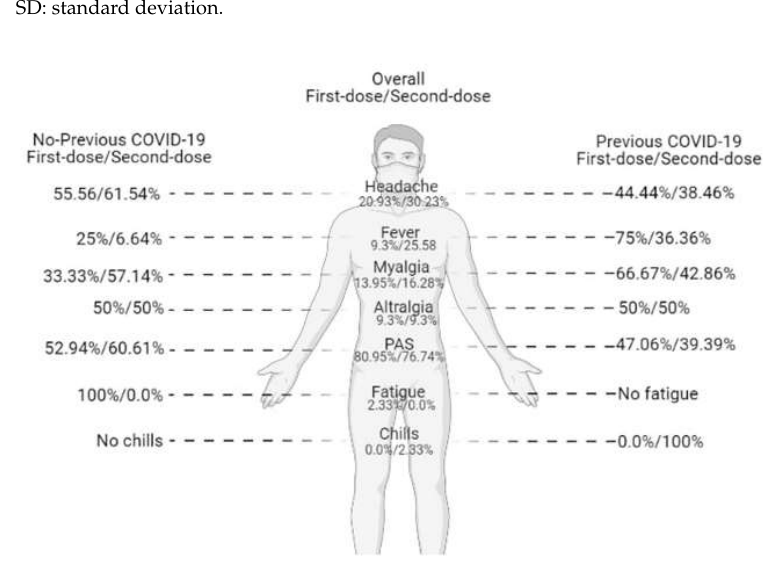
Figure 1. Symptoms reported by the participants after the first and second BTN162b2 doses in the no-previous COVID-19 and previous COVID-19 groups.